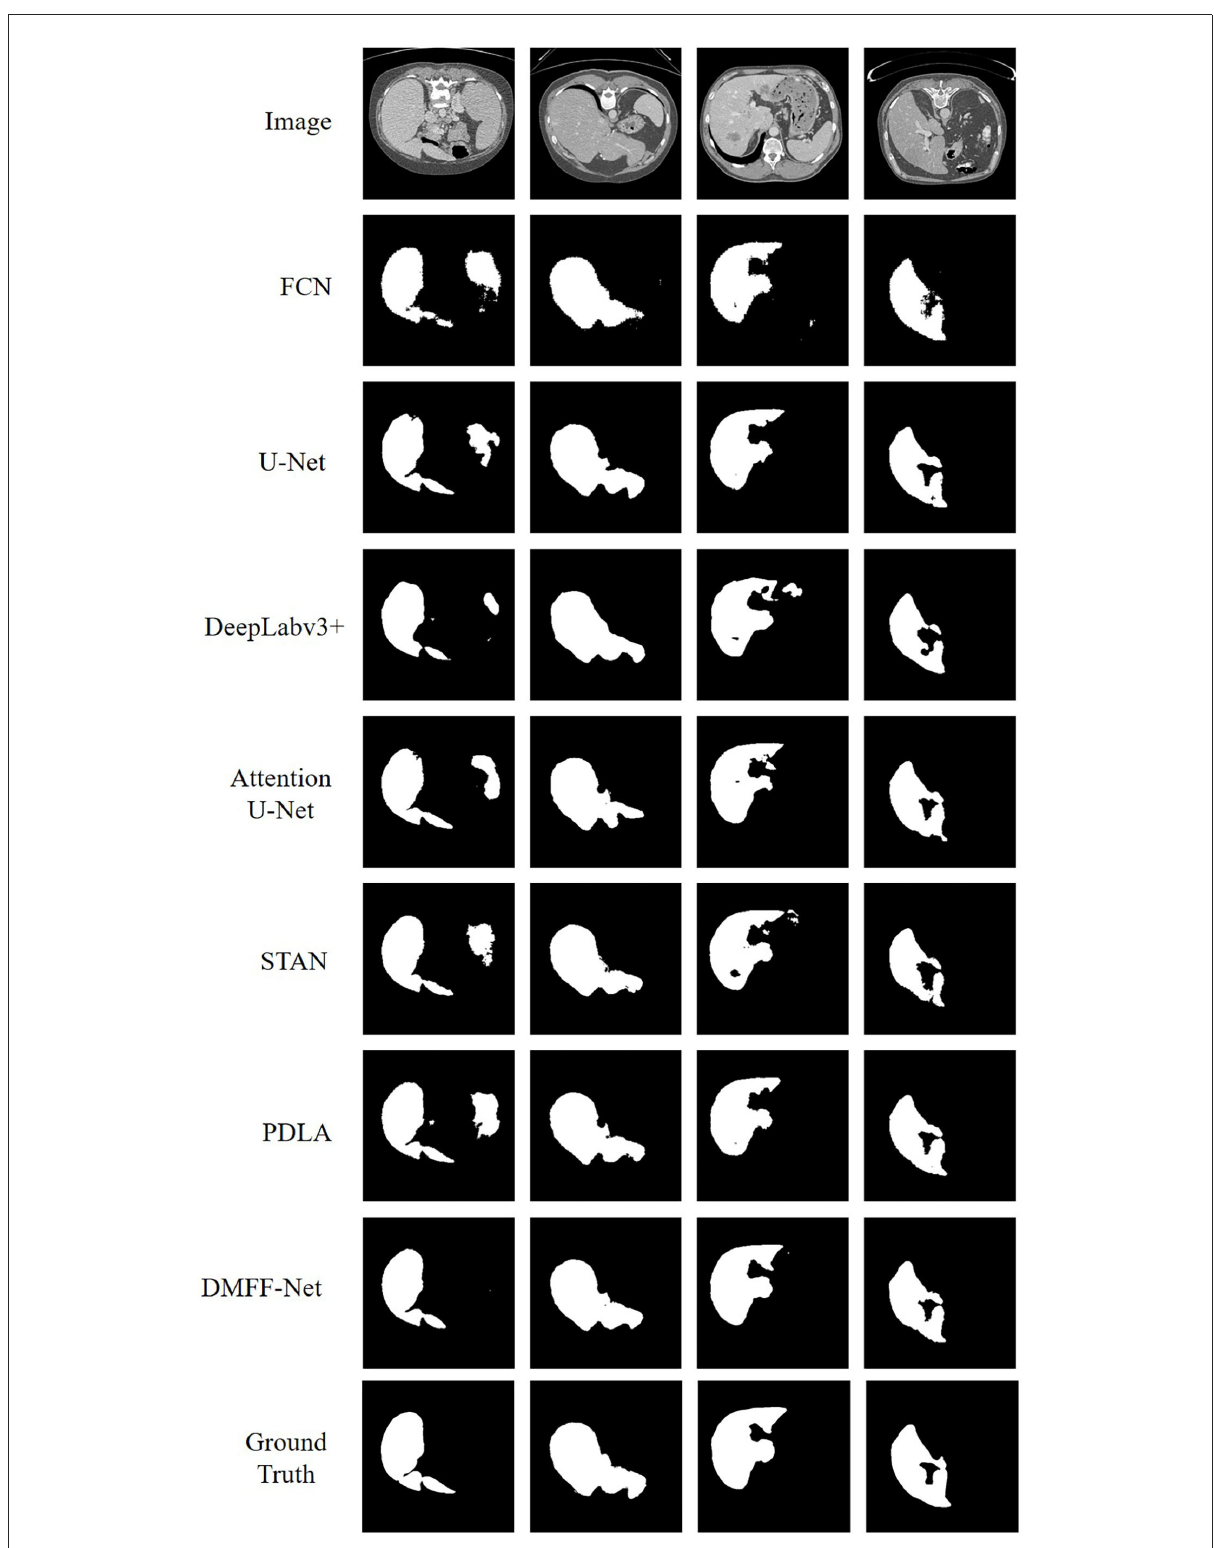
FIGURE11 Qualitative comparison of liver segmentation results between DMFF-Net and other medical image segmentation